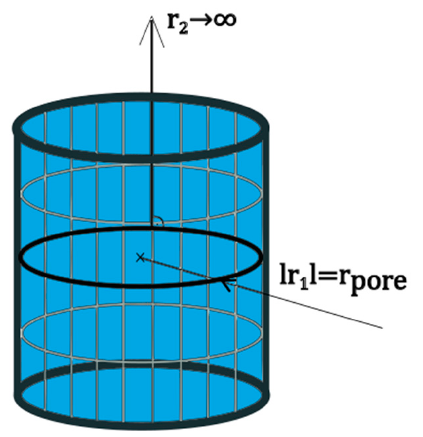
Figure 4. Liquid layer inside cylindrical pore.